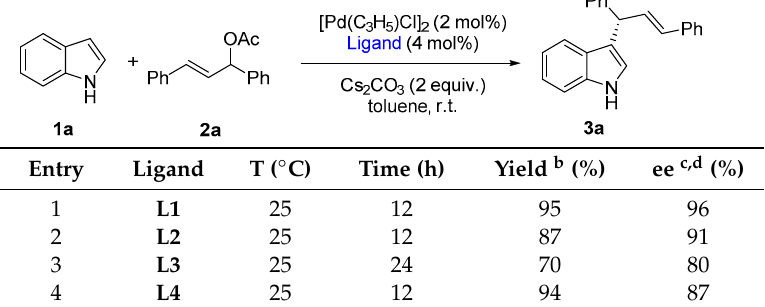
Table 1. Evaluation of ligands for Pd-catalyzed allylic alkylation of indoles. a